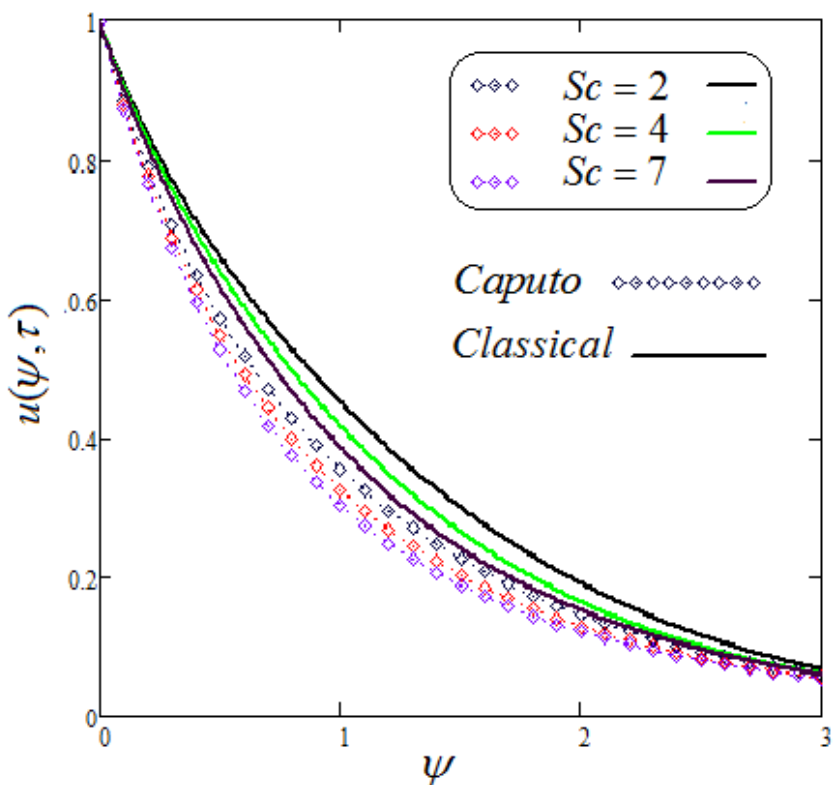
Figure 15. Trace of velocity comparison for dissimilar values of Sc .